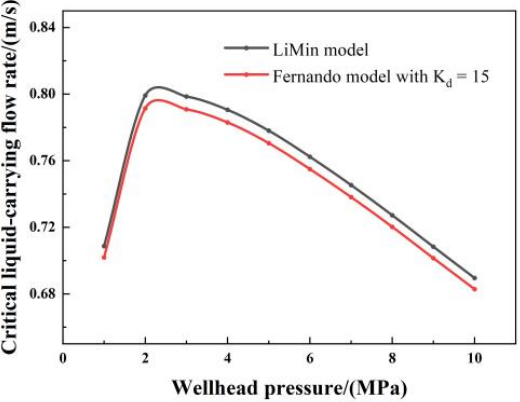
Figure 4. Drag coefficient for inclined section determined using the Li Min and Fernando models.